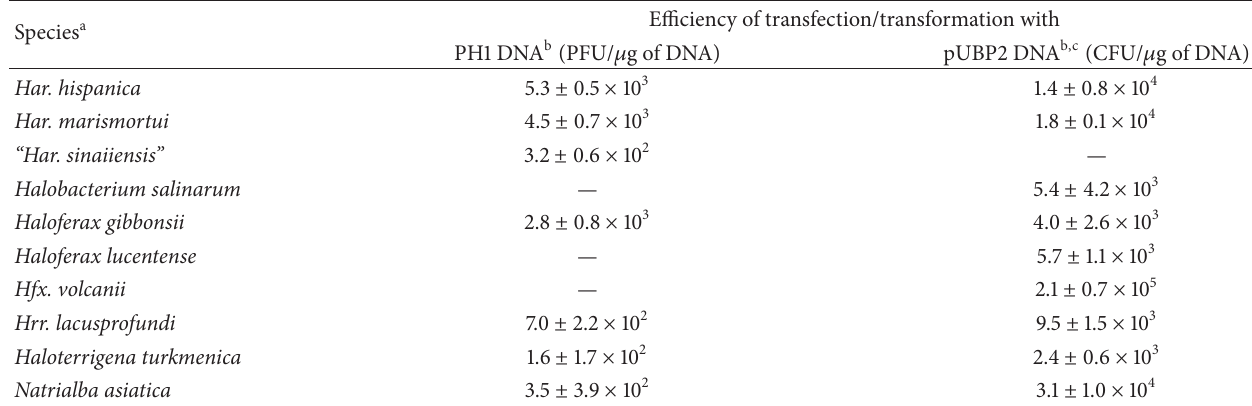
Table 6: Transfection of haloarchaea by PH1 DNA.